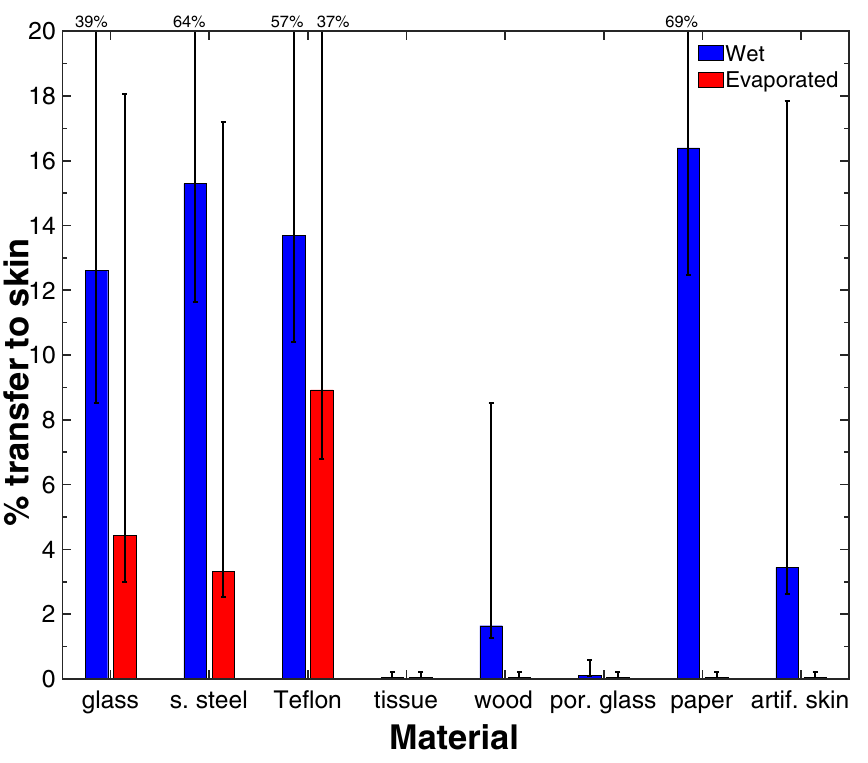
Figure 1. Mean percentage transfer to an artificial finger from various solid material during a 5 s contact with a 3 N (299.2 ± 1.2 g) load with no lateral motion (i.e., no rubbing). Error bars are the comparison intervals from ANOVA with two factors: the material and the time, which corresponds to wet or evaporated. MATLAB was used to create the figure and to calculate the ANOVA. The error bar is asymmetric because of the exponential distribution of measurement residuals. When the upper bound is off-scale, it is indicated by a number. The time to adsorb the droplet on porous surfaces was as follows: tissue and porous glass, immediate; wood, 1–2 min; and paper, 2.5 min. Note that the transfer is high for non-porous solids and is measurable when the 1 µL test drop is wet (10 s) or has evaporated (30 min). Each data point was obtained from three independent measurements that are tabulated in Supplementary Table